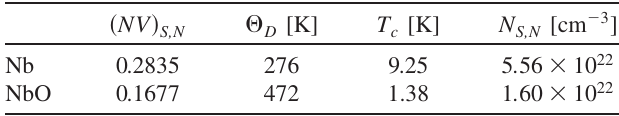
TABLE I. Superconducting parameters of Nb and